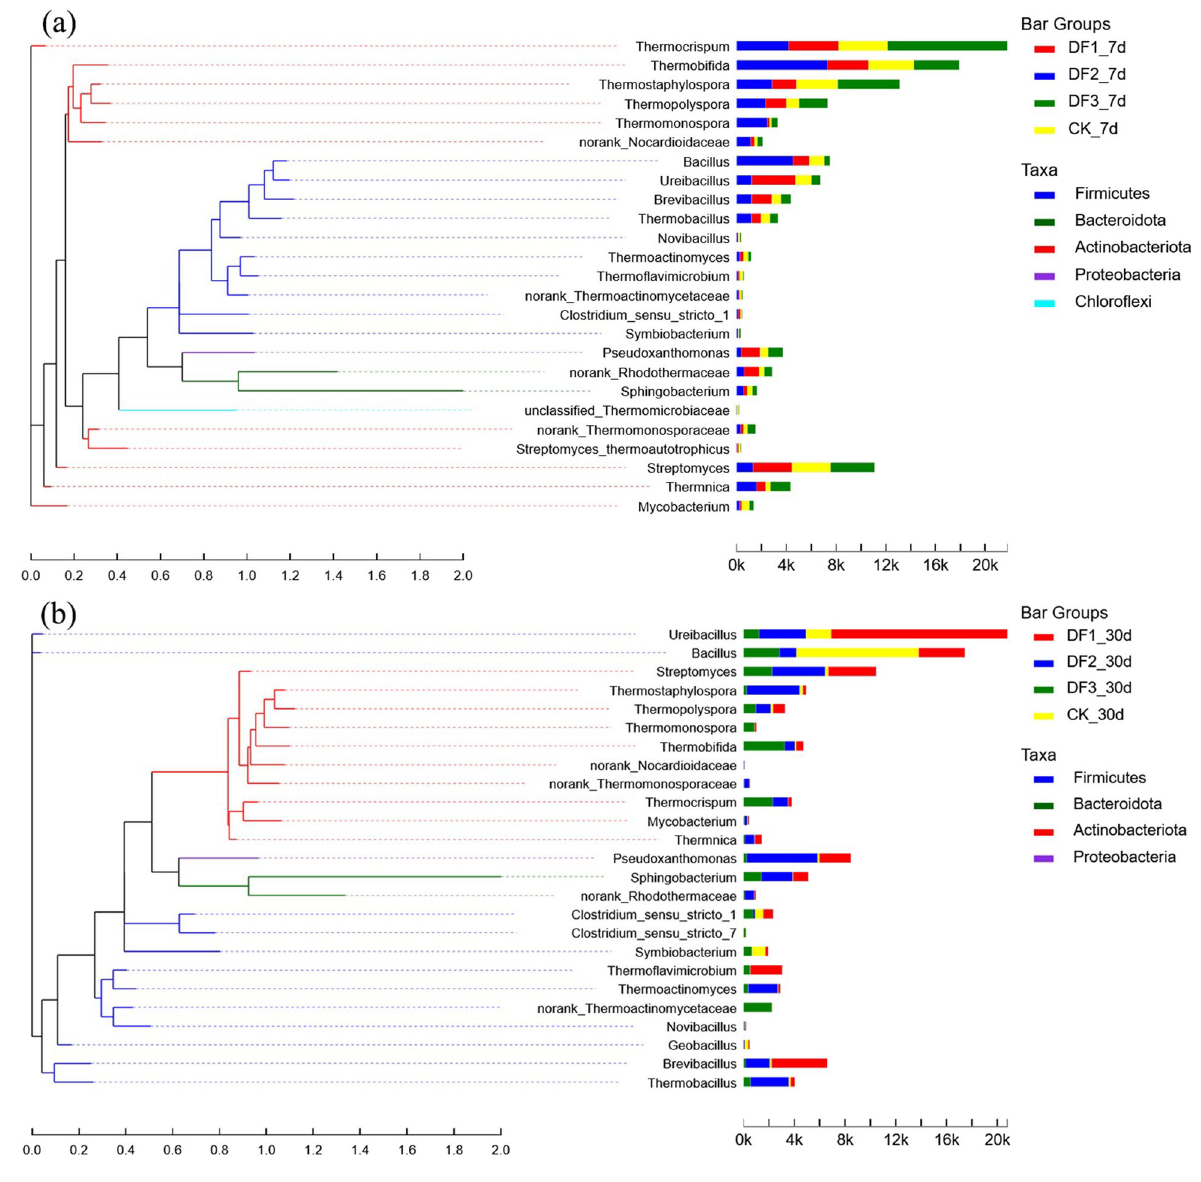
Figure 7. Phylogenetic tree of thermophilic bacteria during the high-temperature ( a ) and decomposition stages ( b